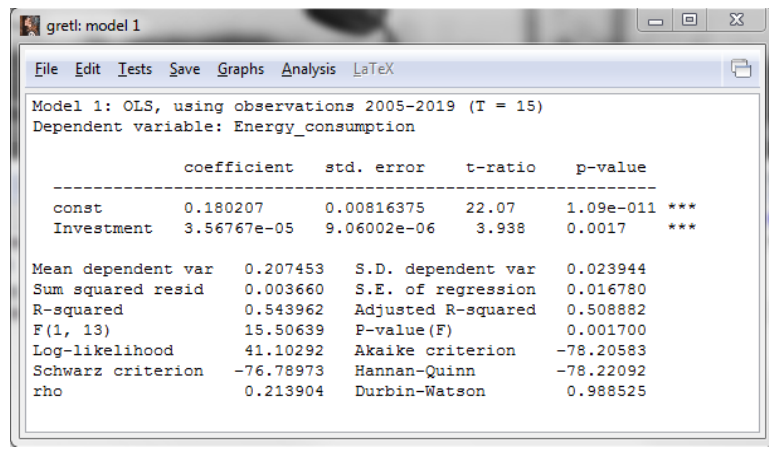
Figure 9. Econometric model.